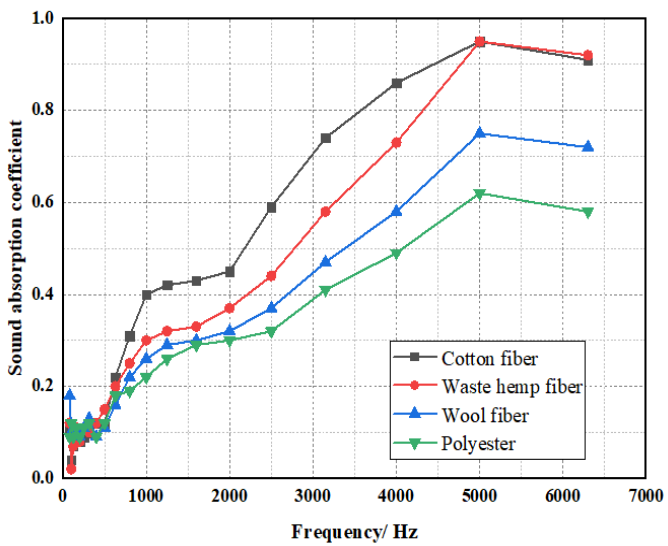
by the test are seen in Figure 8. As can be seen in Figure 8, the sound-absorbing coefficient curves of the four fiber aggregates had similar trends, i.e., the absorption coefficient increases gradually with the increase in frequency, among which the high-frequency sound-absorbing performance of the waste hemp fiber was the best, with a maximum sound-absorbing coeffi- sound-absorbing coefficient of 0.95 and the corresponding sound-absorbing frequency of cient of 0.95 and the corresponding sound-absorbing frequency of 5000 Hz. 5000 Hz.